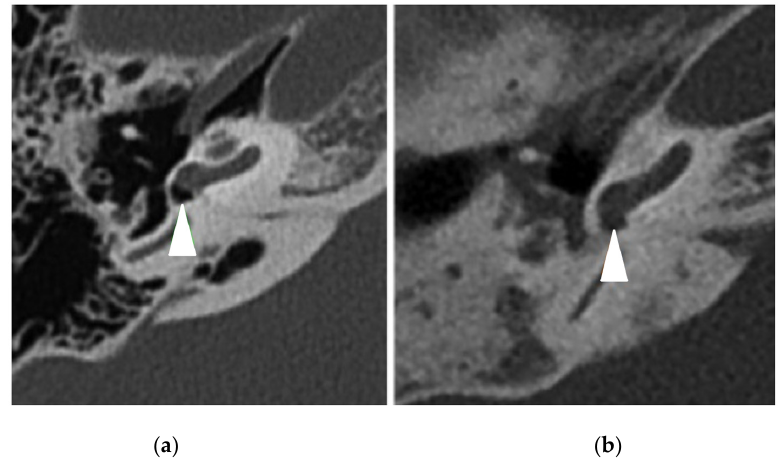
Figure 2. Right temporal bone CT scans in axial view showing (white arrowheads) ( a ) a normal round window (control patient) and ( b ) a filling of the round window (PCD patient).